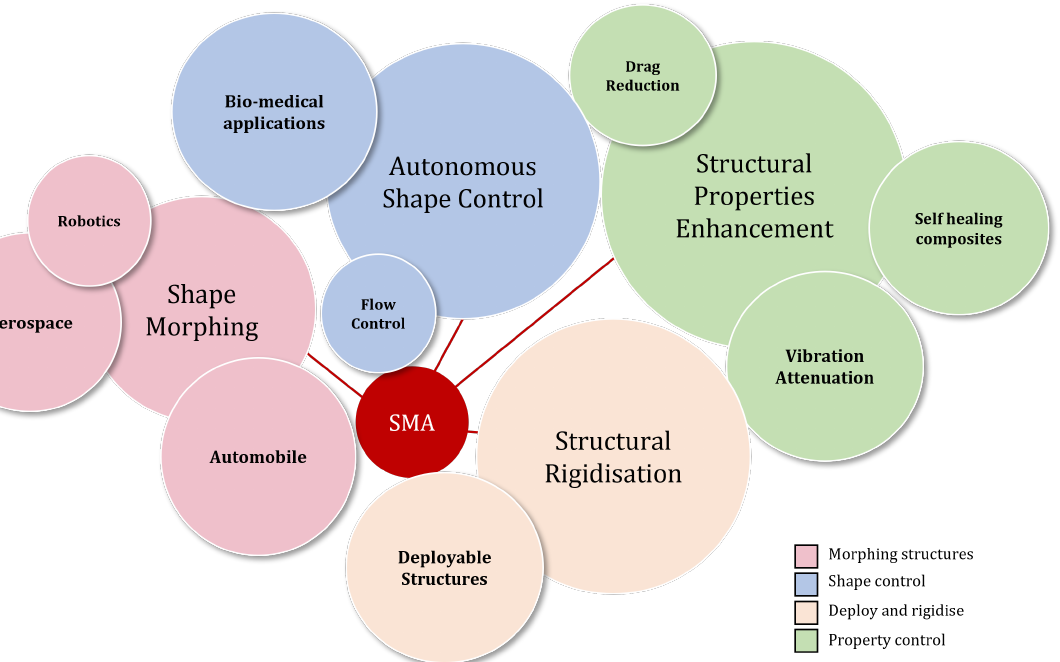
Figure 3. Major application domain of Shape Memory Alloys. The Superelastic property finds more commercial applications as compared to the Thermal Shape Memory Effect. The use of SMA in smart wearables is currently in its laboratory and experimental